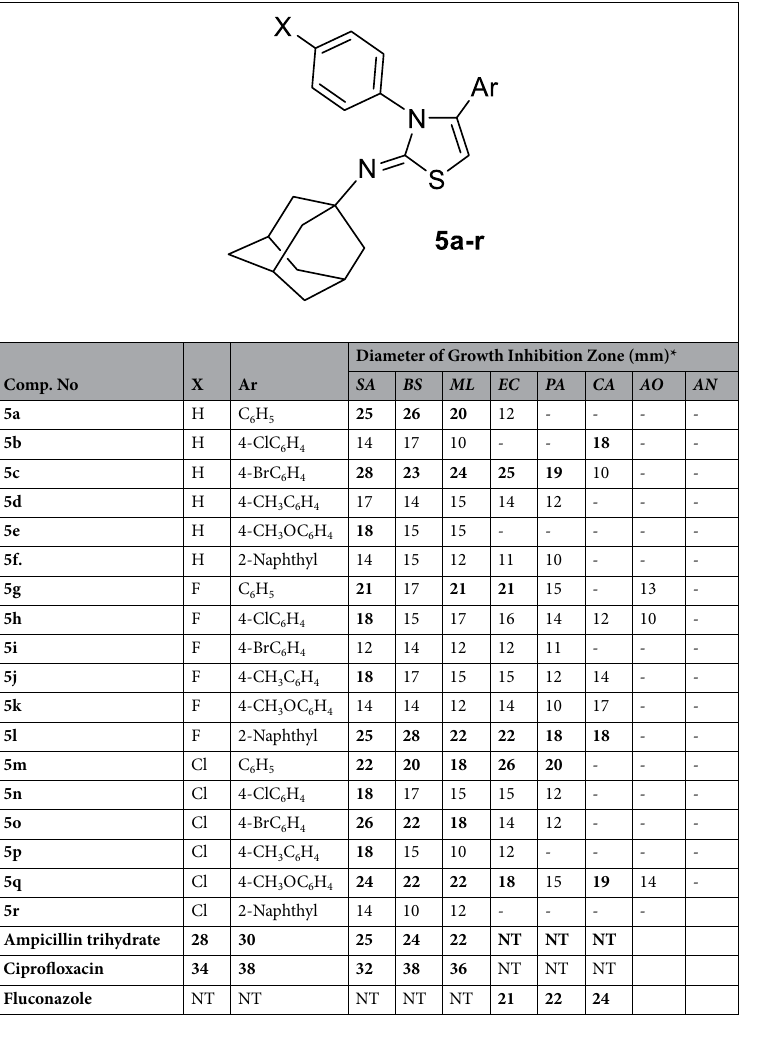
Table 1. Antibacterial and antifungal activities of compounds 5a-r (200 μg/8 mm disc), the broad-spectrum antibacterial drugs Ampicillin trihydrate, Ciprofloxacin and the antifungal drug Fluconazole (100 μg/8 mm disc) against the Gram-positive bacteria Staphylococcus aureus IFO 3060 ( SA ), Bacillus subtilis IFO 3007 ( BS ) and Micrococcus luteus IFO 3232 ( ML ), the Gram-negative bacteria Escherichia coli IFO 3301 ( EC ) and Pseudomonas aeruginosa IFO 3448 ( PA ) and the pathogenic fungi Candida albicans IFO 0583 ( CA ), Aspergillus oryzae IFO 4177 ( AO ) and Aspergillus niger IFO 4414 ( AN ). NT not tested. *-Inactive (inhibition zone < 10 mm). Significant values are in